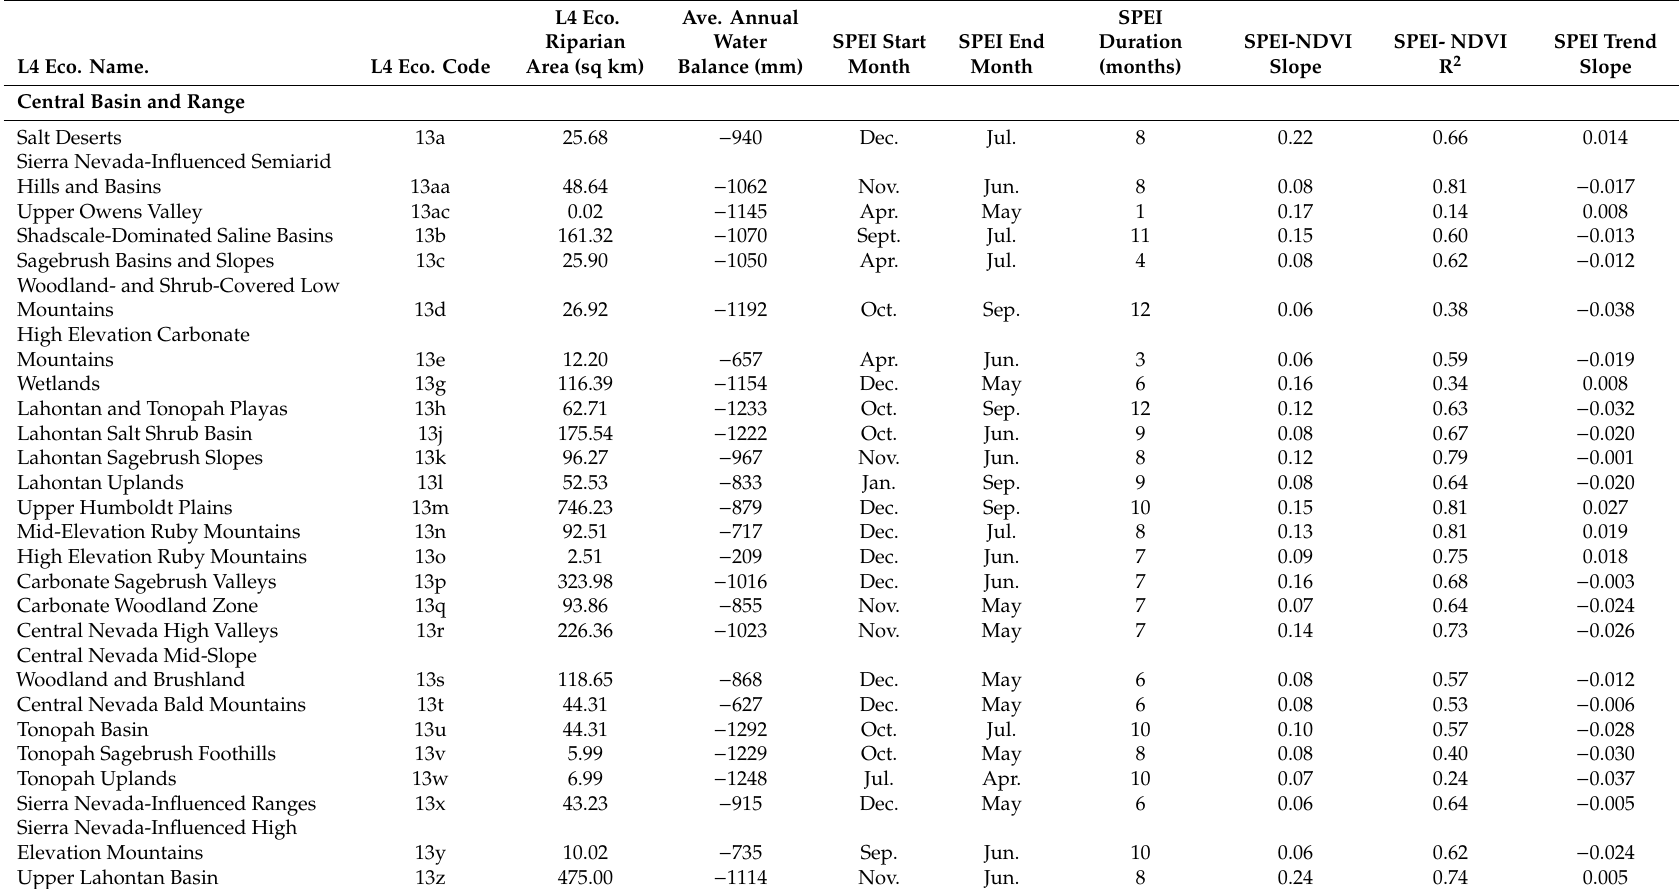
Table 1. Relations between the Standardized Precipitation–Evapotranspiration Index (SPEI) and Normalized Di ff erence Vegetation Index (NDVI) in riparian areas within EPA Level IV ecoregions in